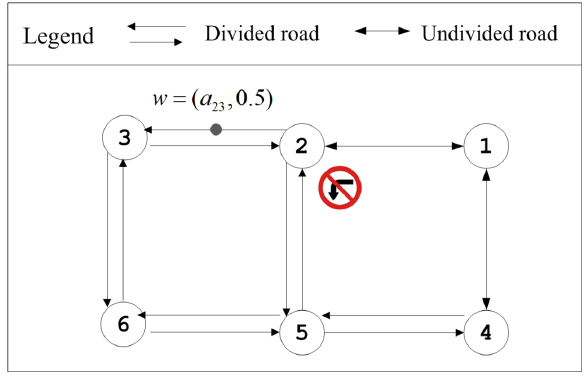
Figure 2. A simple road network.